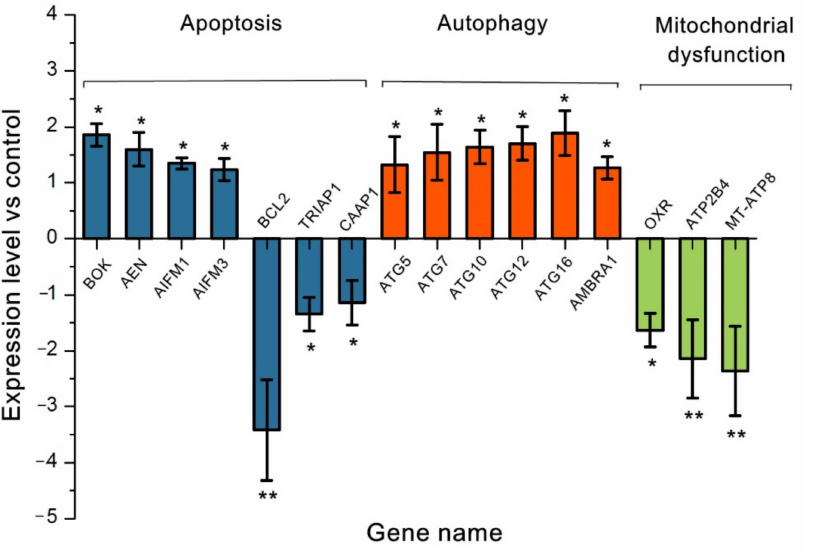
Figure 9. Expression variation of related genes at RNA transcription level after treatment with 80 µ M BUP. Values are expressed as the mean and SEM values of three replicates. * p ≤ 0.05 and ** p ≤ 0.01 vs. the negative